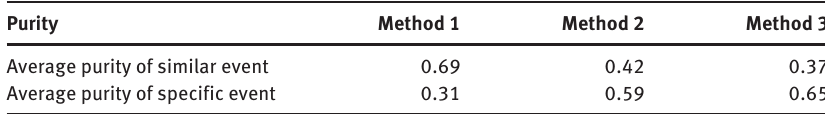
Table 3. Purity of Similar and Specific Events for the Three Methods.